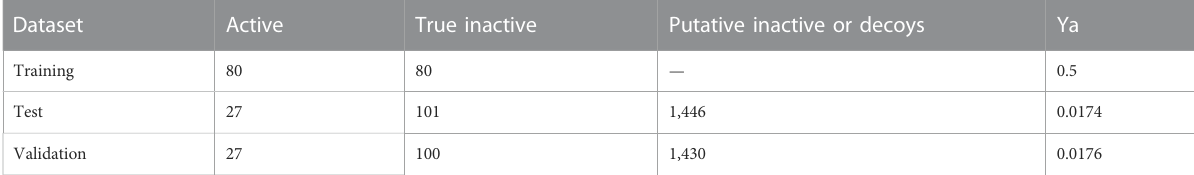
TABLE 1 Active and inactive compound composition of the training, test and validation sets. The test and validation sets were expanded with decoys to provide chemical libraries to be used in retrospective screens 1 and 2, respectively. Ya (yield of active compounds) refers to the proportion of active compounds in the corresponding set.